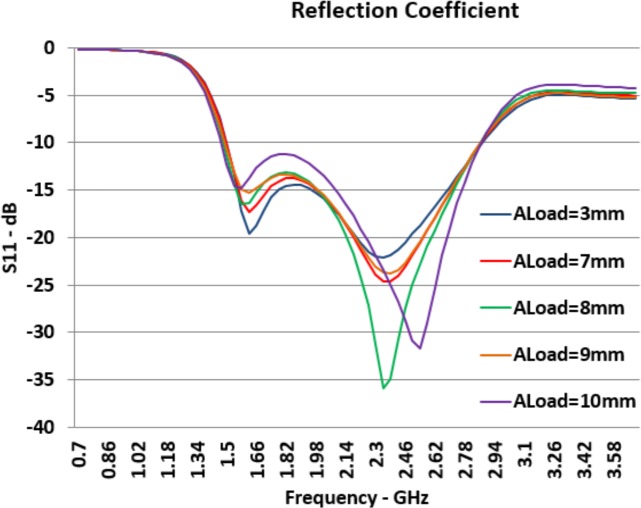
Effects of ALoad Changes on Reflection Coefficient (S11).